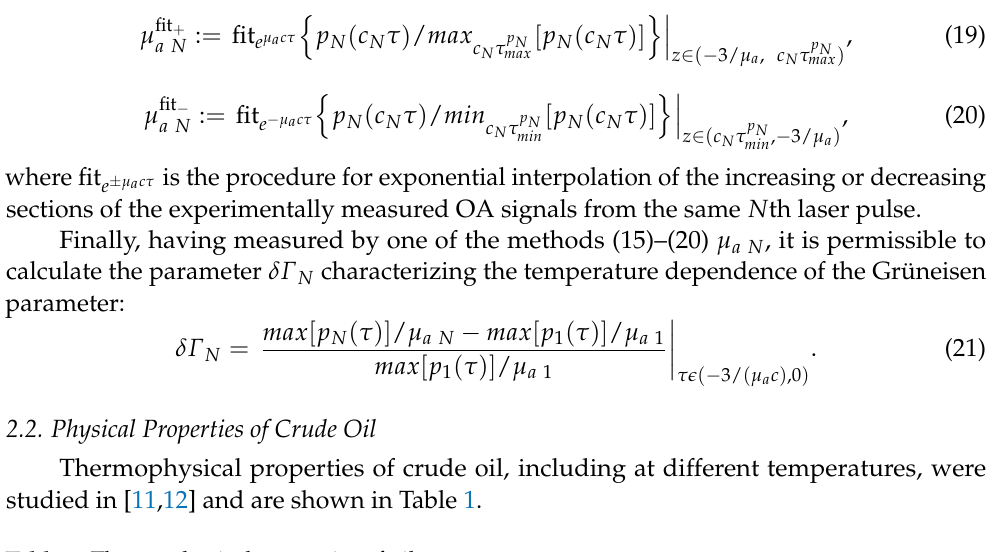
Table 1. Thermophysical properties of